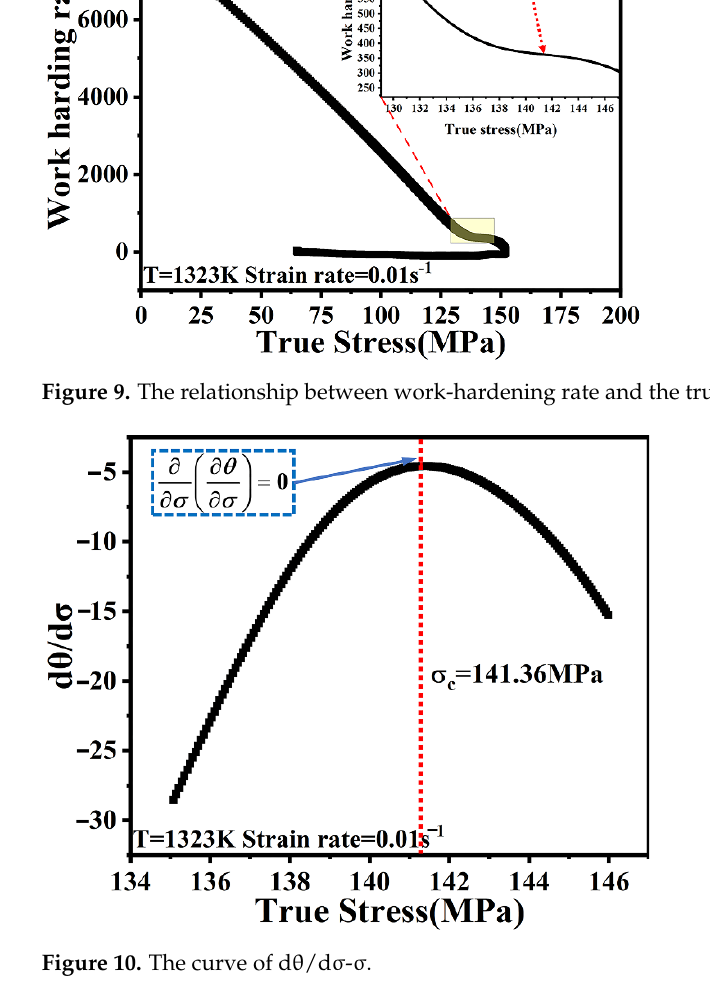
Figure 10. The curve of dθ/dσ - σ. Table 1. Critical strain ( ε c ) and critical stress ( σ c ) obtained from the work-hardening